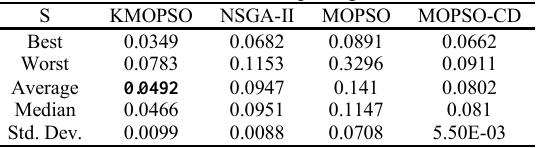
Table 9 . Results of the spacing metric for POL.